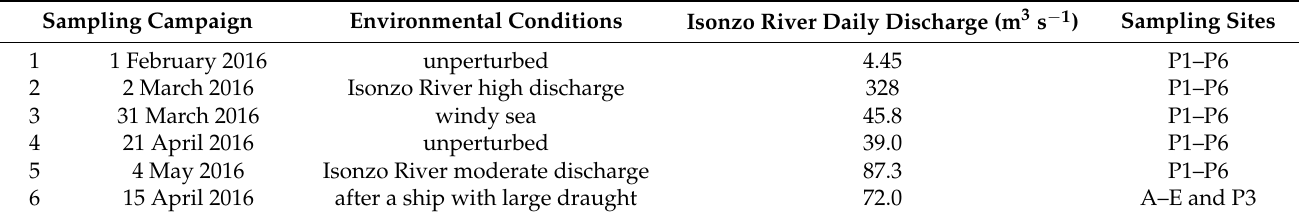
Table 1. Environmental conditions and Isonzo River daily discharge (m 3 s − 1 ) during the six sampling campaigns performed to collect surface and bottom water samples at the six investigated sites in the Bay of Panzano. Sampling